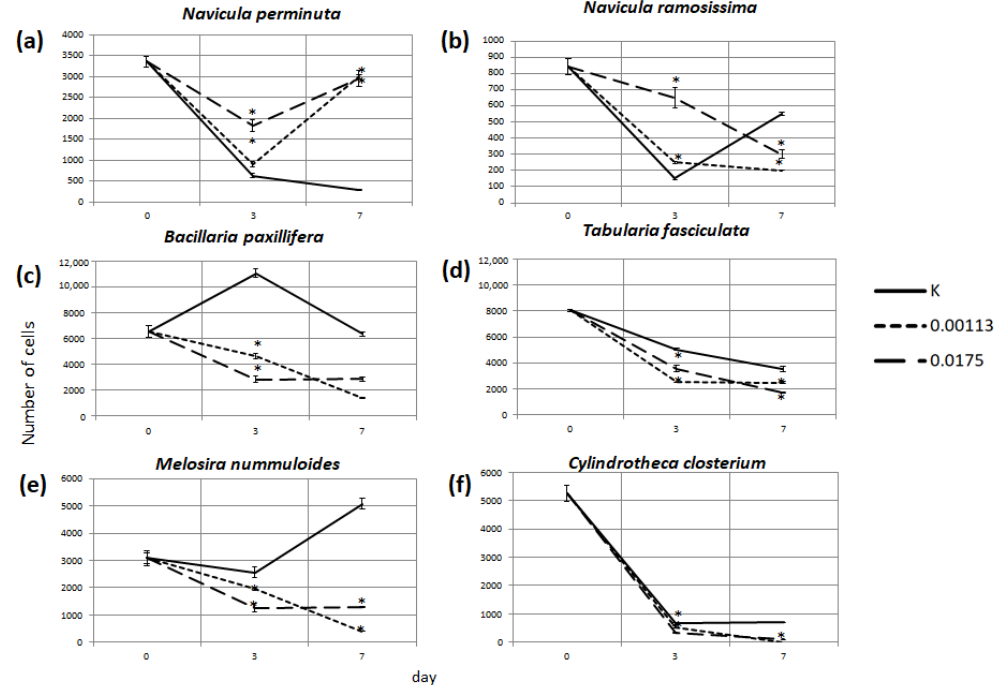
Figure 6. Number of cells of selected microalgae during experiment: K—control solution; 0.00113—the concentration of 1.13 × 10 − 3 g · dm − 3 [BMIM]Cl; 0.0175—the concentration